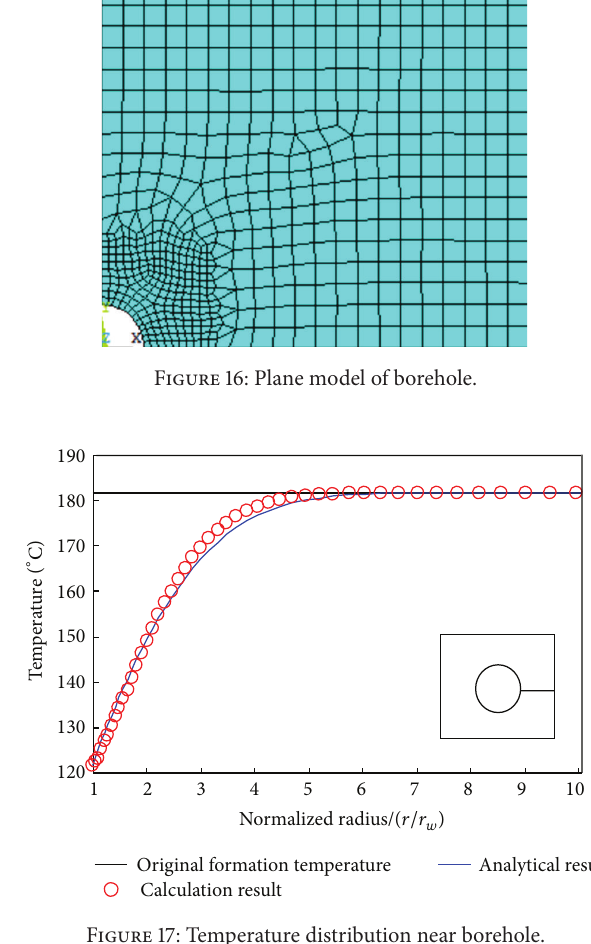
Figure 17: Temperature distribution near